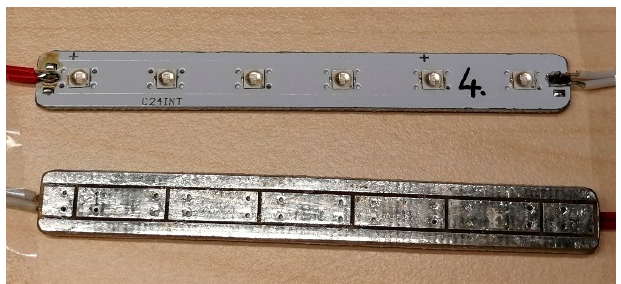
Figure 13. The sample mid-power LEDs mounted on FR4 strips; the printed circuit boards were provided with increased thermal interfaces for better cooling capabilities.